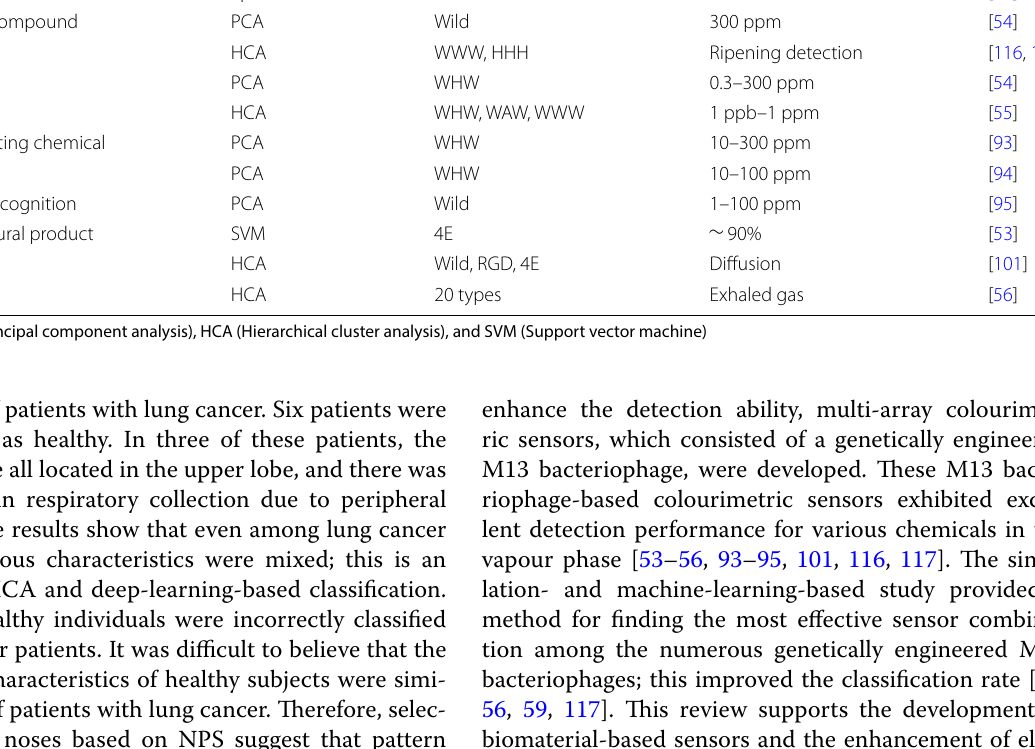
Table 1 M13 bacteriophage‑based sensors